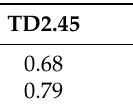
Figure 4. XPS analysis for typical samples: ( a ) XPS survey of samples; ( b ) N 1s scan of sample. Table 1. Percentage of N Atomic.